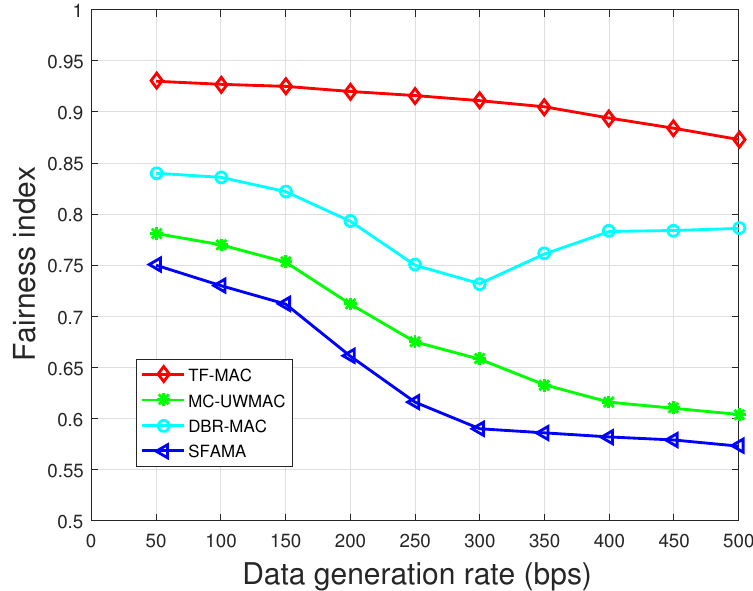
Figure 20. Comparison of the fairness index in the dense network. Figure 21 shows the fairness indices of different layers in TF-MAC under the sparse network. Different layers have different fairness due to the uneven distribution of nodes, but they are all greater than 0.8. In addition, the fairness index in each layer decreases with an increase in the data generation